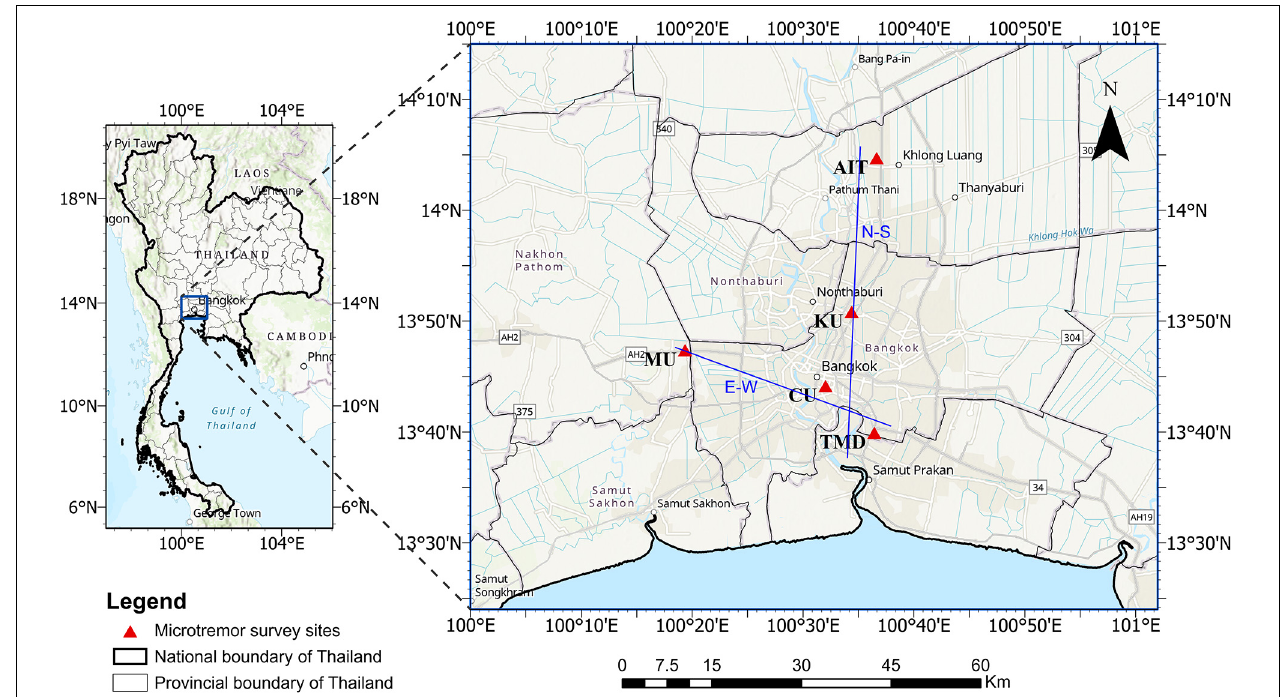
FIGURE 3 | Left: Location of Bangkok in Thailand. Right: Location of survey stations.